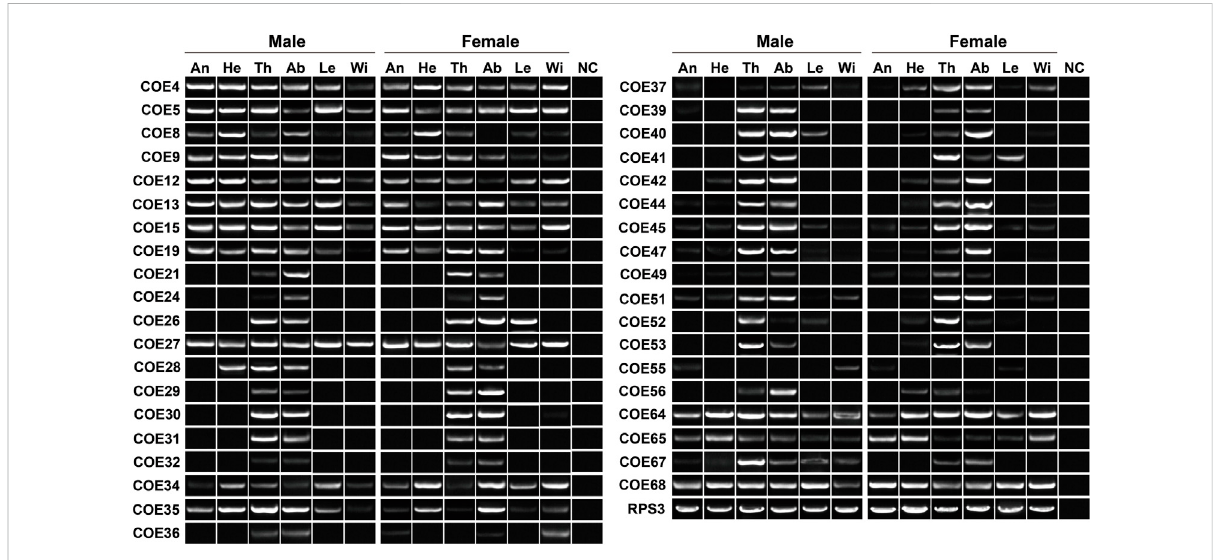
FIGURE 6 Expression pattern of 38 COE genes in various tissues of P. antennata . The abbreviation of tissues is seen in Table 1. NC, negative control using sterile water as the